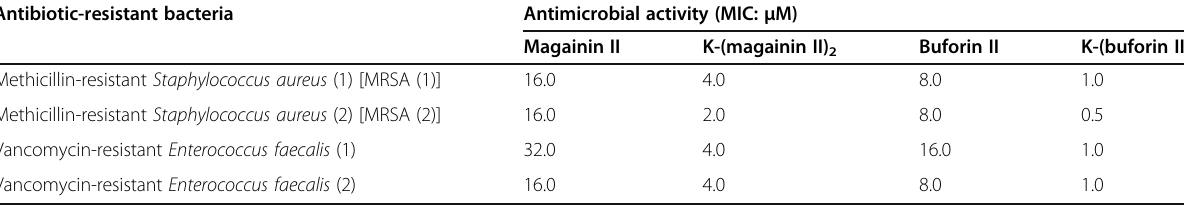
Table 3 Antimicrobial activities of peptides against antibiotic-resistant bacterial isolates Antibiotic-resistant